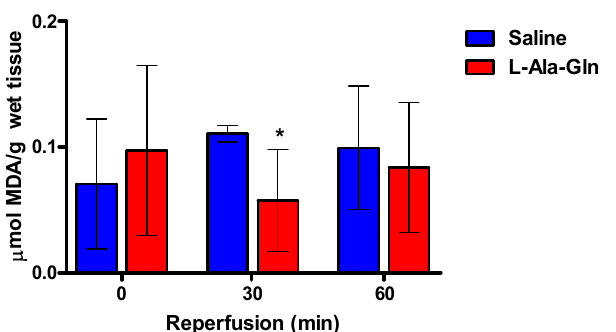
FIGURE 3 - MPO activity (MPO units per milligram of fresh tissue) in cerebral tissue of saline and Ala-Gln pretreated gerbils. Bars represent means±SD of control (blue bars) and L-Ala-Gln (red bars) groups at the end of the ischemia (0 min) and during reperfusion (30 and 60 minutes).